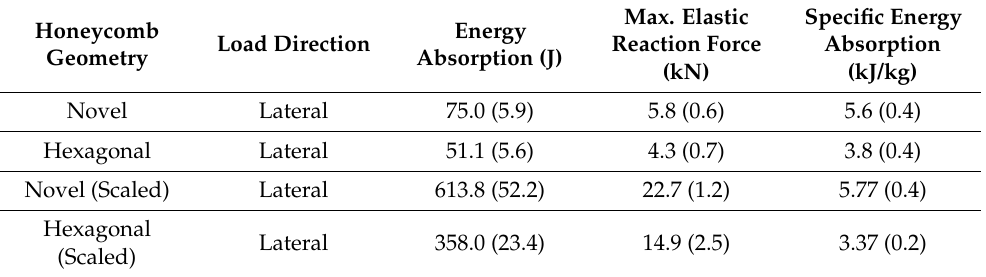
Table 4. Average values and standard deviations for the experimentally measured energy absorption, maximum reaction force at the initial elastic peak, and energy absorption per unit mass, for the novel and hexagonal geometries under lateral loads and for both dimensional scales.